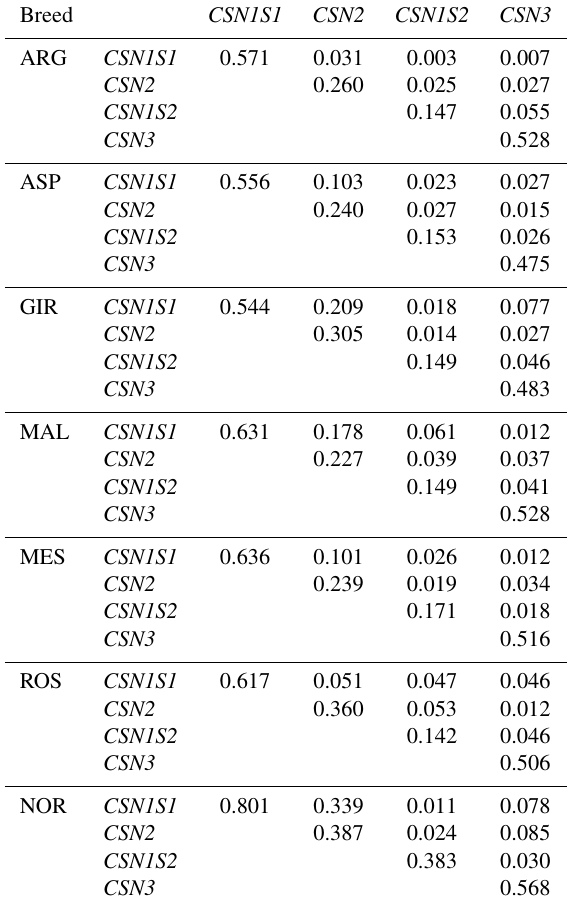
Table 4. Average linkage disequilibrium within and between casein loci per breed.